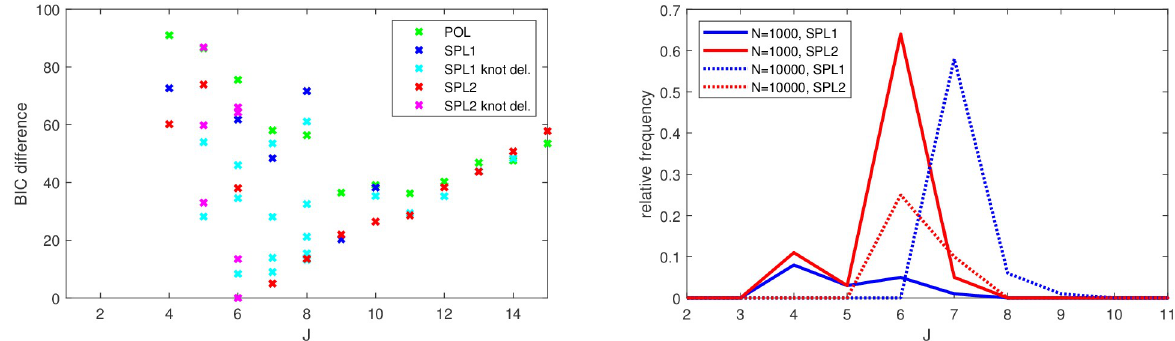
Fig 3. Test case 6: Left: Example of model selection, corresponding to the example shown in Fig 2. Sample size is N = 2000. Right: Relative frequency out of 250 realisations of picking a particular model as the SPDE. The spline models encompass models without and with knot deletion. https://doi.org/10.1371/journal.pone.0259111.g003 Table 6. Test case 14: Number of realisations out of 100 in which certain combinations of logarithmic boundary terms are chosen for the various semiparametric estimators and different sample sizes. Model